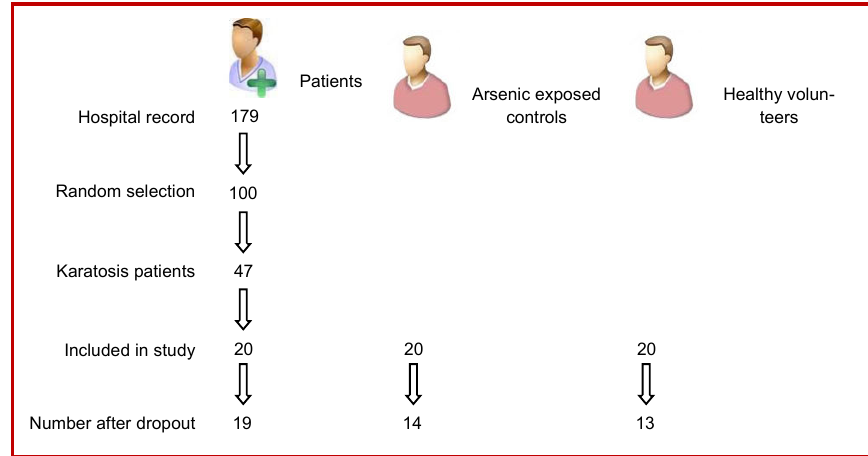
Figure 1: Flow-chart of subject